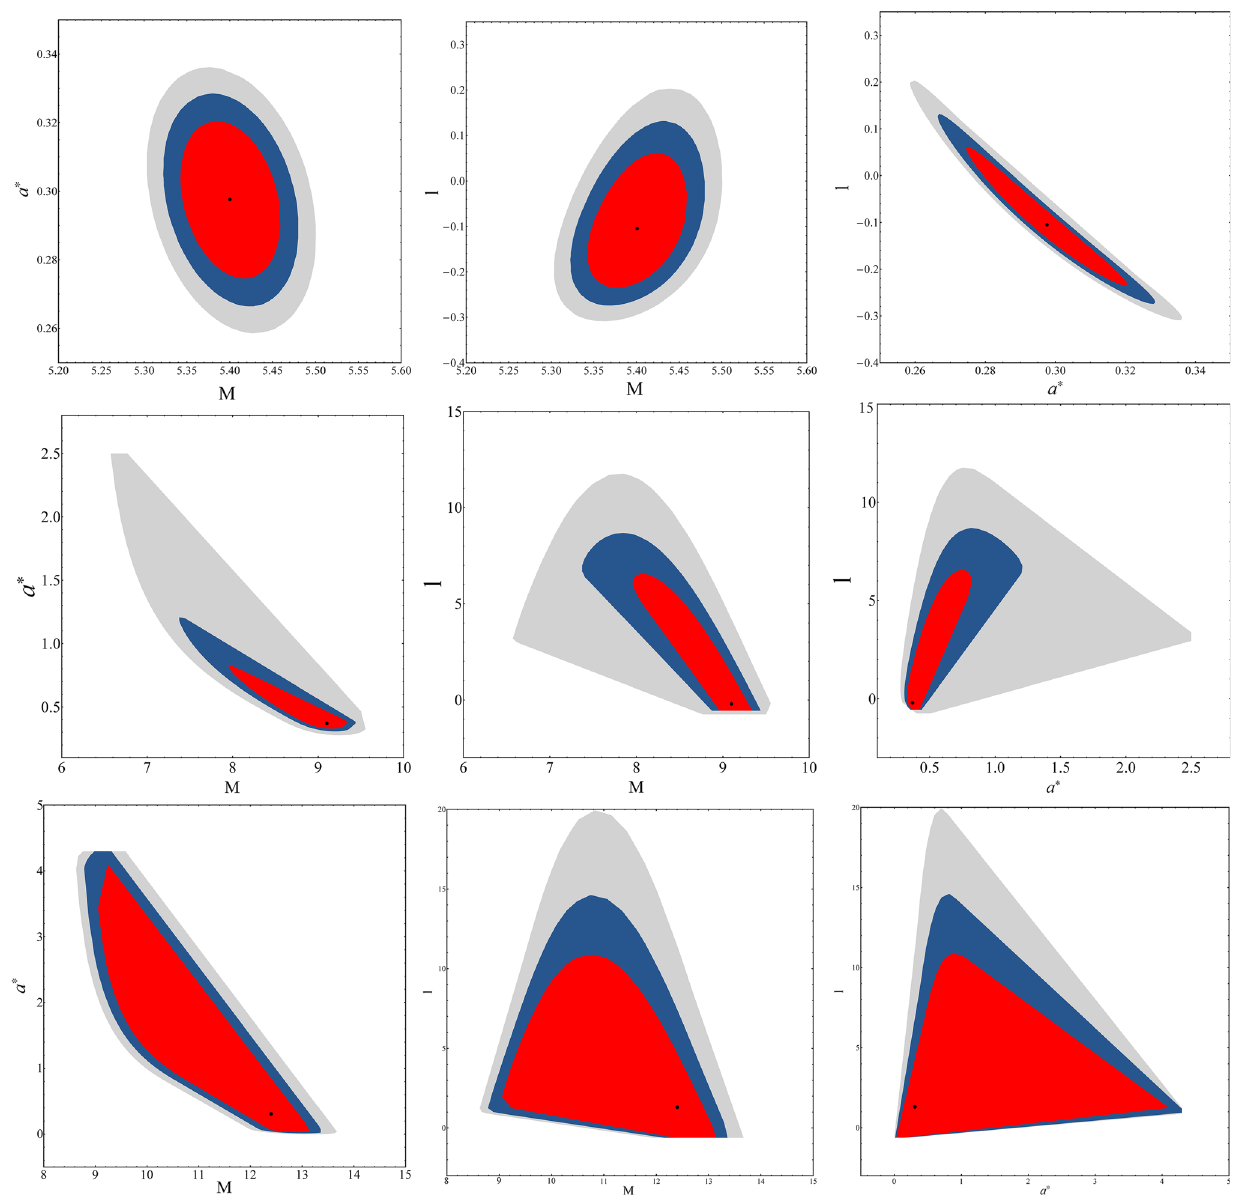
Fig. 5 Constraints on the parameters of the rotating black hole in Einstein-bumblebee theory (4) from current observations of QPOs within the relativistic precession model. The top, middle and bottom rows correspond to the constraint from GRO J1655-40, XTE J1550-